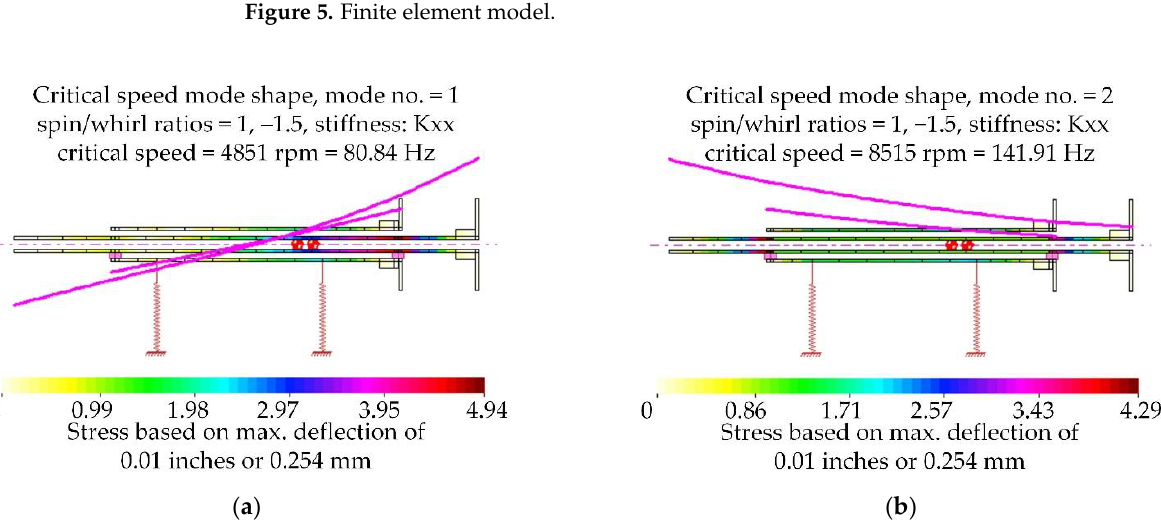
Figure 5. Finite element model. Figure 6. The mode shape. ( a ) The first-order mode shape; ( b ) the second-order mode shape.